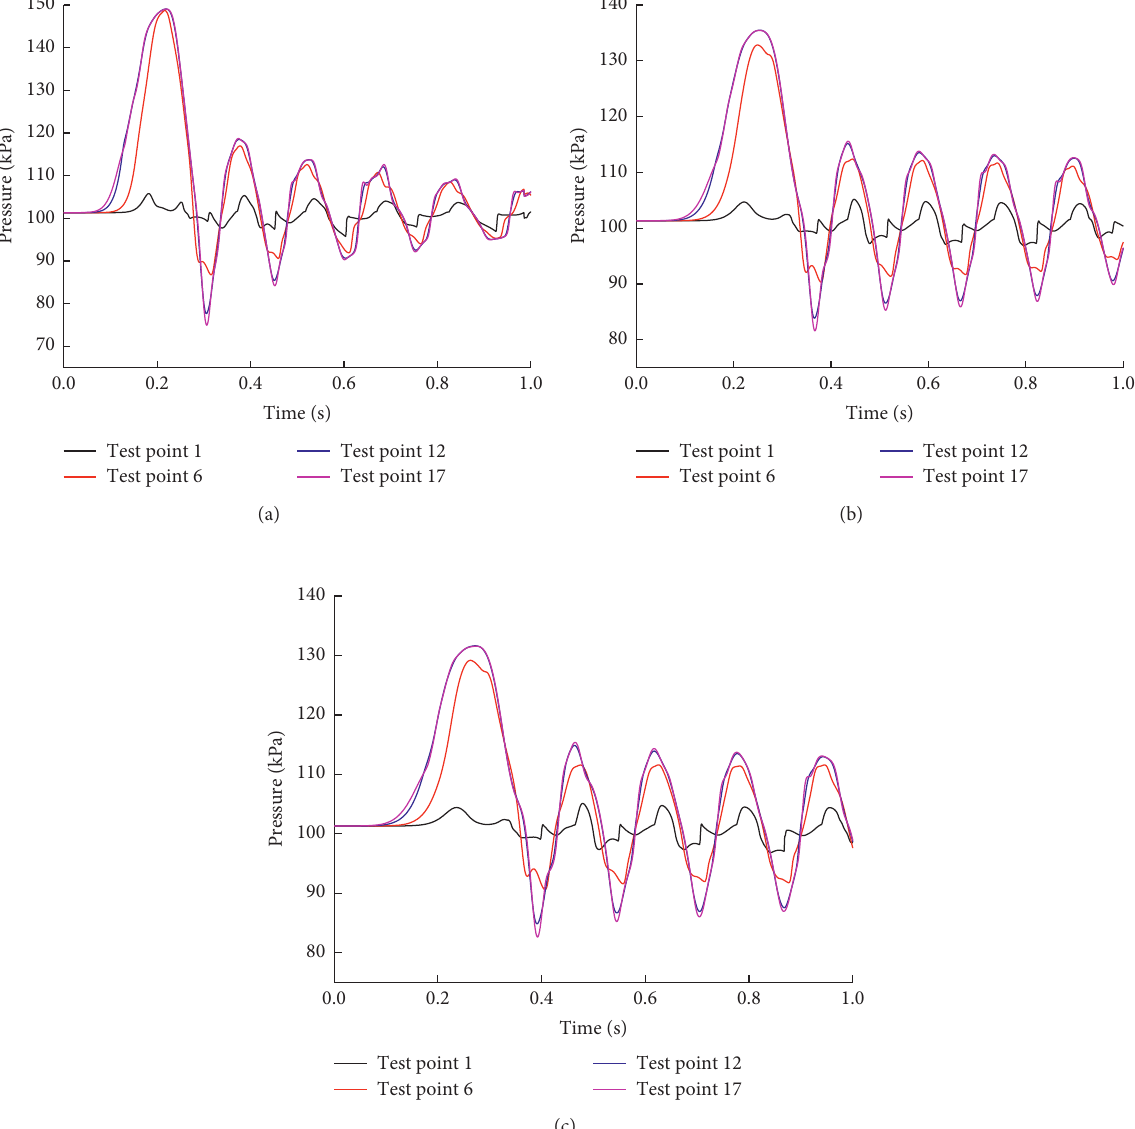
8 H 18 ; (b) 4% C 8 H 18 ; (c) 6% C 8 H 18